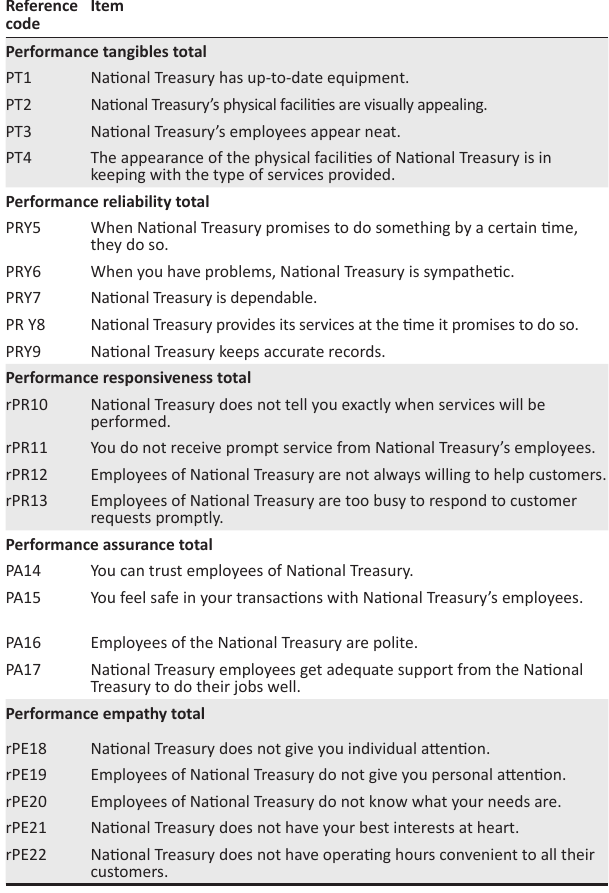
TABLE 1b: Measuring instrument used in the study. Service expectations (Part